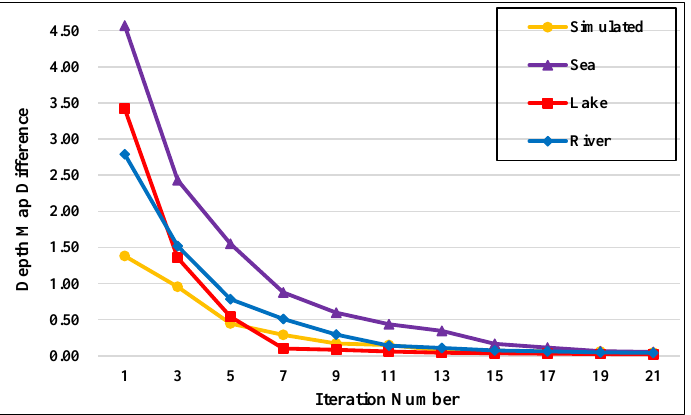
Figure 14. The results of exploring the generalization ability of each depth estimation network.